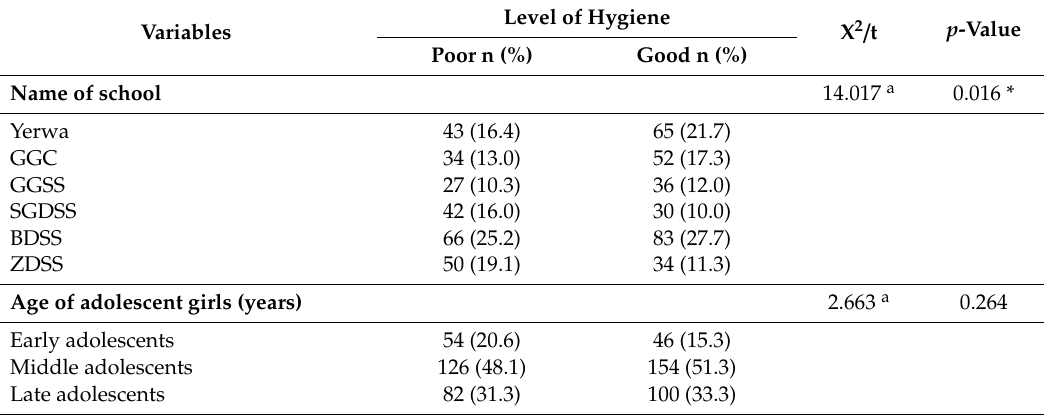
Table 6. Factors associated with